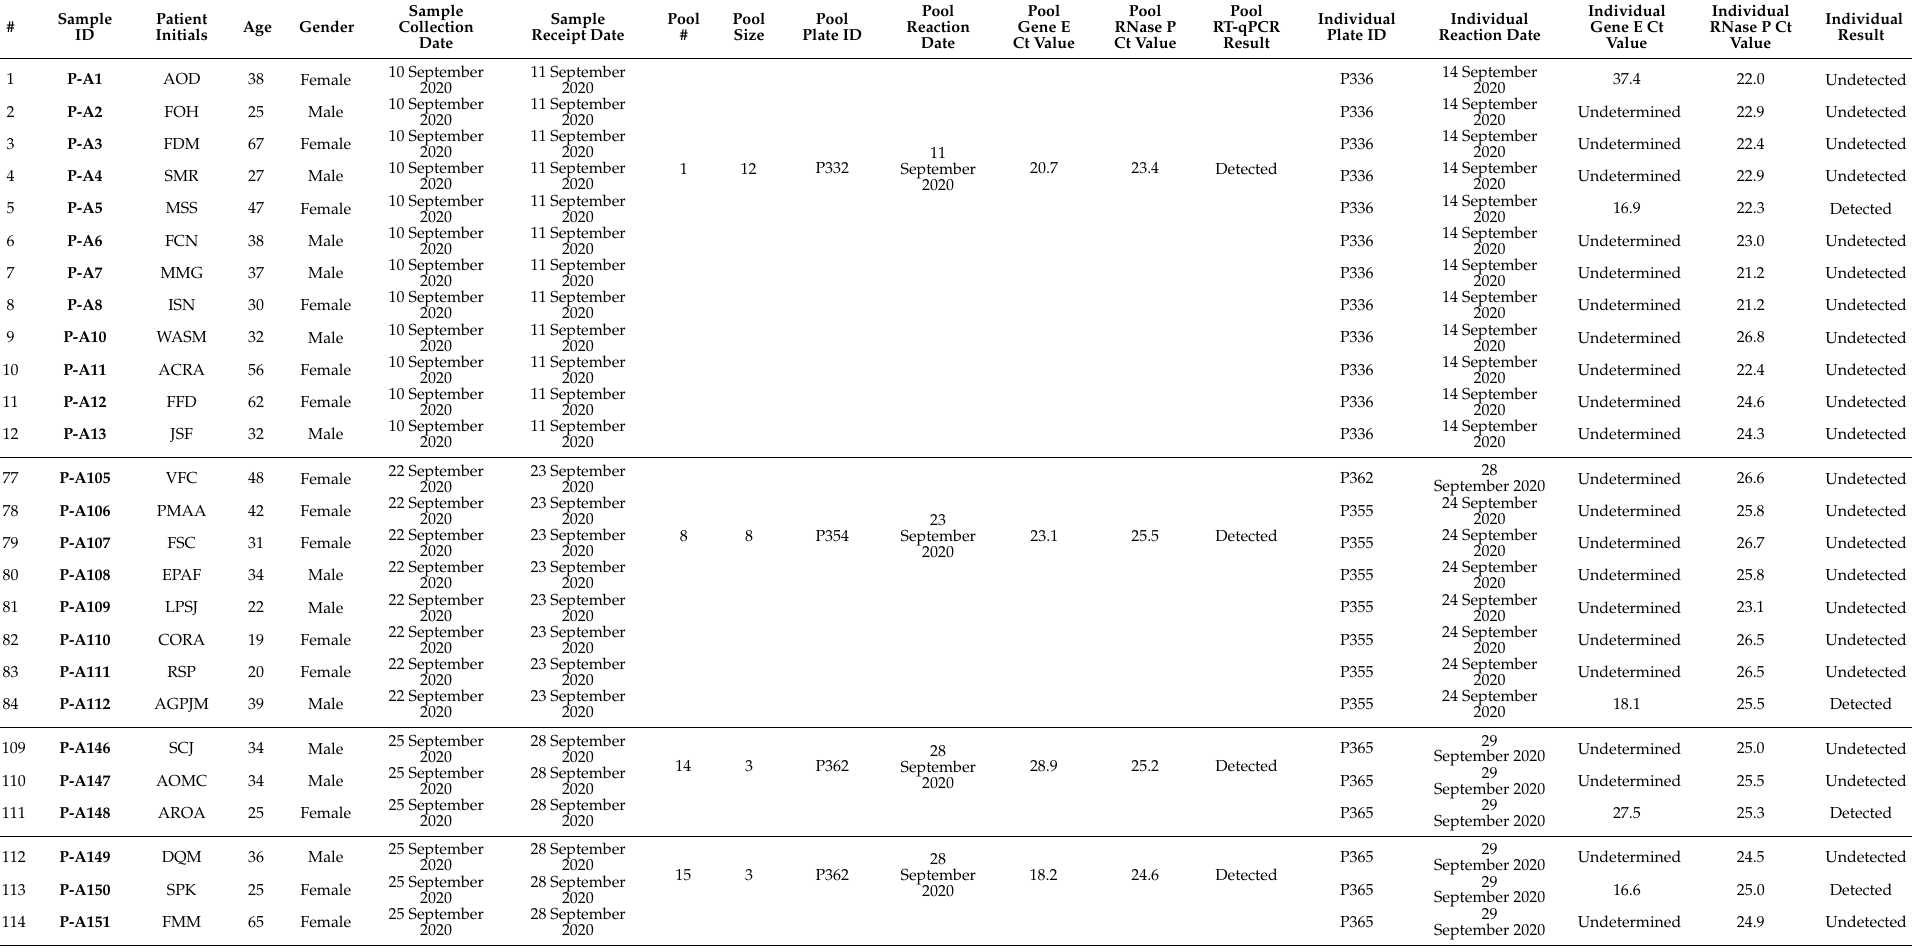
Table A1. Characterization of pools and individual samples tested in the